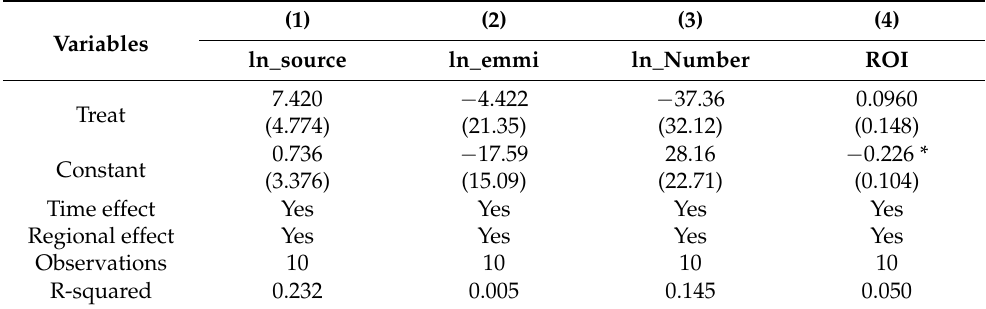
Table 5. Parallel trend test results 1